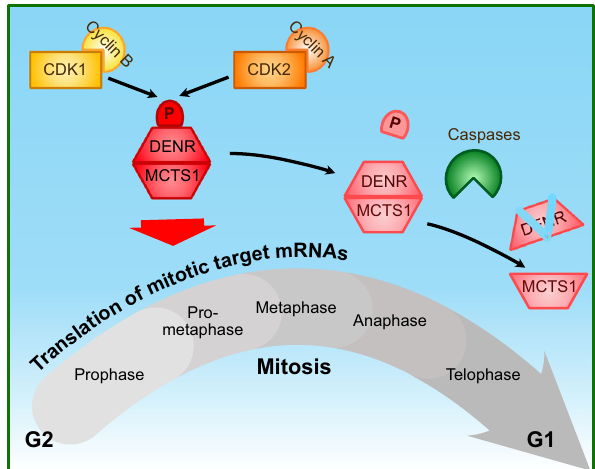
Fig. 6 Schematic summary of DENR regulation in mitosis. During early stages of mitosis, DENR protein is stabilized via phosphorylation of Ser73 which enables it to promote translation of target genes involved in mitosis. As of anaphase, DENR phosphorylation on Ser73 decreases, concomitant with a caspase-dependent decrease in DENR protein levels as cells exit